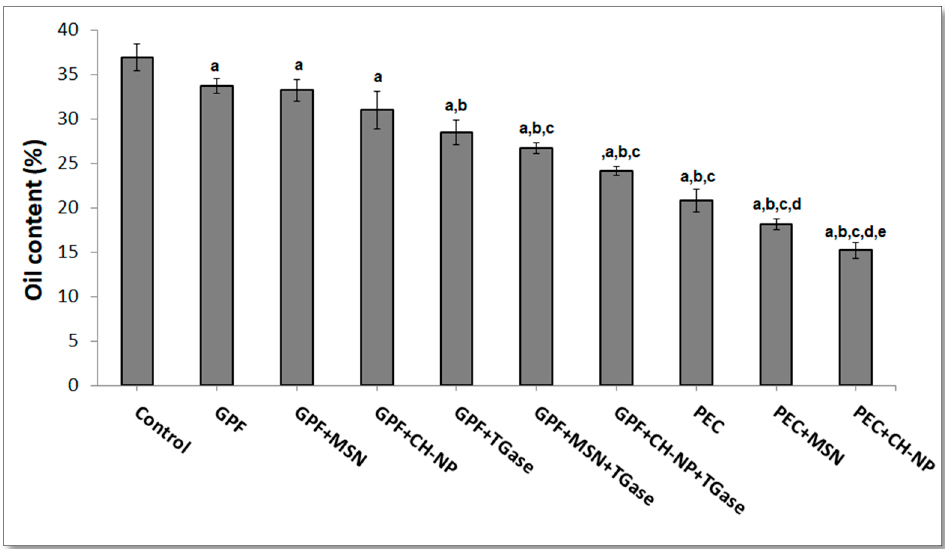
Figure 4. Influence of di ff erent hydrocolloid coatings on oil content of fried kobbah. Columns “a” indicate values significantly di ff erent from the control sample; columns “b” report values significantly di ff erent from grass pea flour (GPF)-coated kobbah; columns “c” indicate values significantly di ff erent from GPF + mesoporous silica nanoparticles (MSN)-coated kobbah or GPF + transglutaminase (TGase)-coated kobbah; columns “d” indicate values significantly di ff erent from pectin (PEC)-coated kobbah; columns “e” indicate values significantly di ff erent from PEC + MSN-coated kobbah. Additional details are reported in the main text.